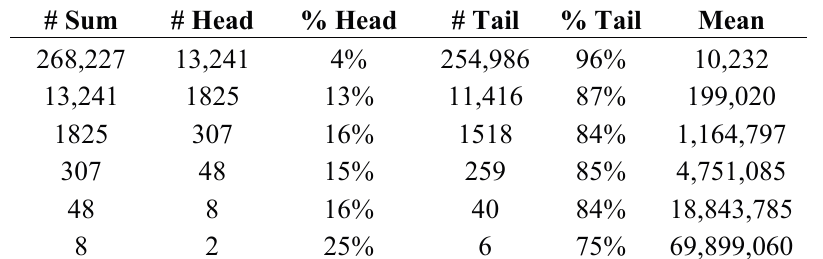
Table 1. Head/tail breaks statistics for user contributions (Note: # = number, % =